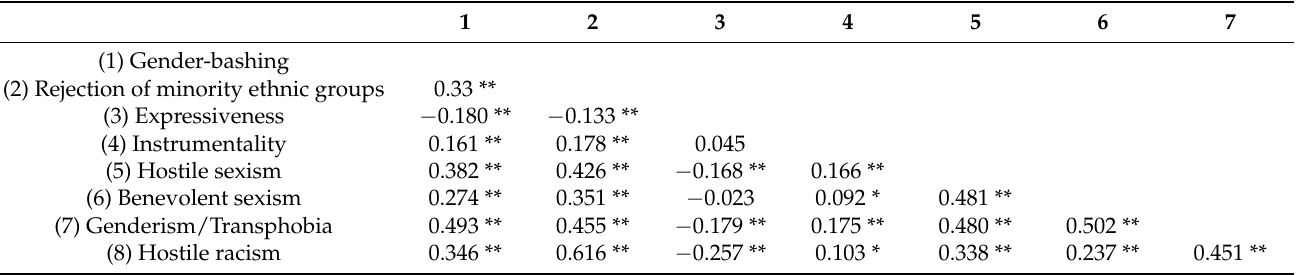
Table 2. Correlations between the study